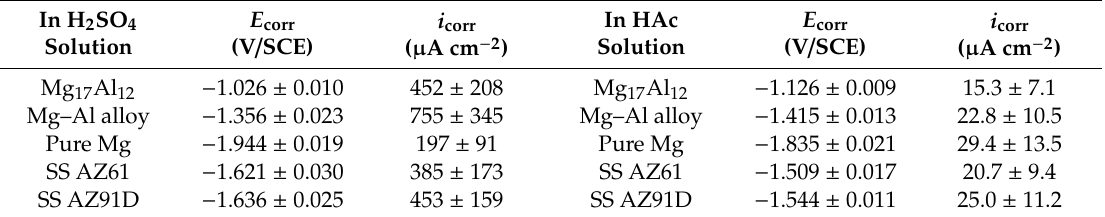
Figure 2. Polarization curves of ( a ) the Mg–Al alloy and SP Mg 17 Al 12 in H 2 SO 4 and HAc solutions and ( b ) pure Mg, SS AZ61, and SS AZ91 in H 2 SO 4 and HAc solutions, respectively. Table 2. Electrochemical parameters obtained from polarization curves in H 2 SO 4 and acetic acid (HAc)